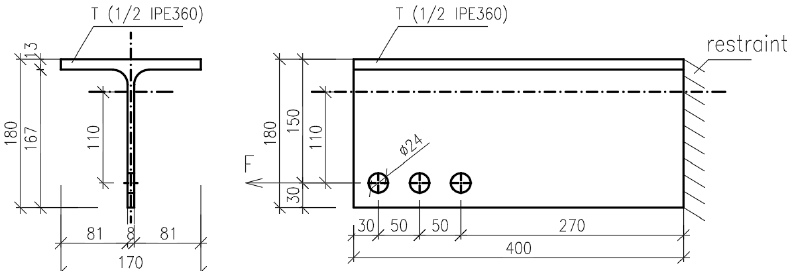
Figure 18. Geometry of the eccentrically loaded bolted connection used for FEM simulation, dimen- sions in mm.